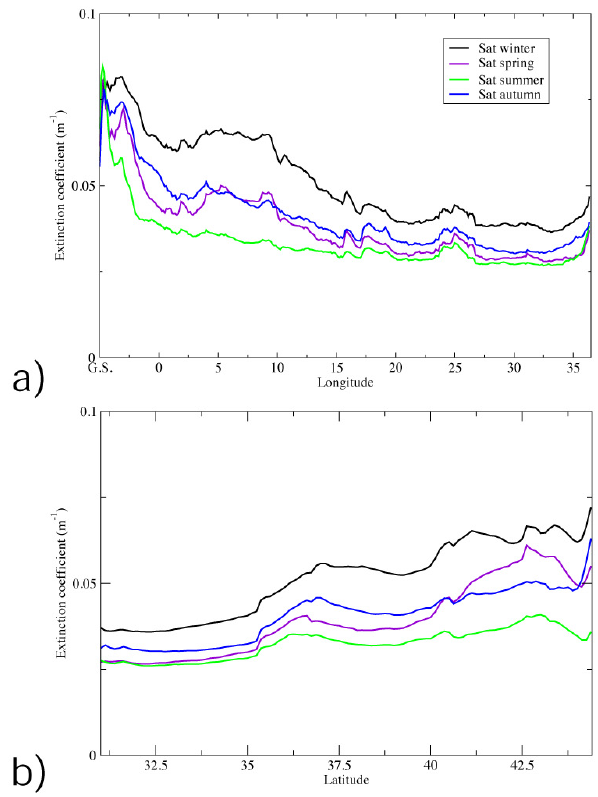
Fig. 3. Satellite extinction factor used in model simulations, zonal averages (upper panel) and meridional averages (lower panel), data provided by